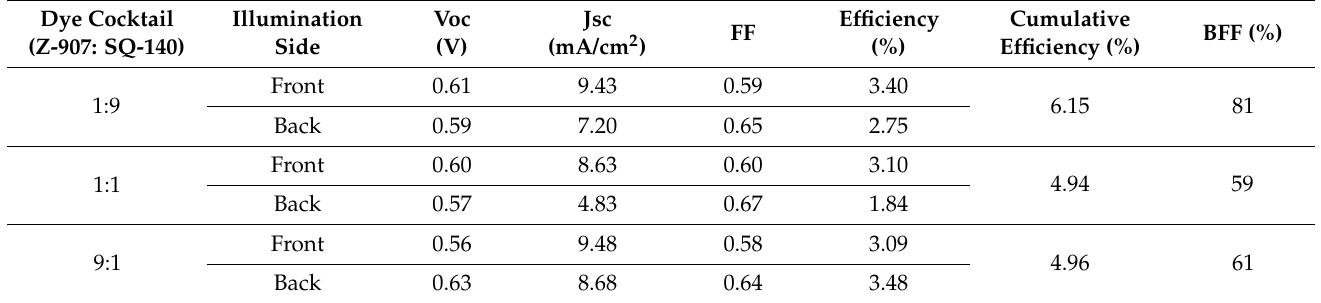
Figure 8. P Photovoltaic characteristics of the BF-DSSCs based on the different dye cocktails of Z-907 and SQ-140 with dye adsorption for 4 h after the front and rear simulated 1 Sun irradiation ( a ) and corresponding absorption for photoanodes taken from different cocktails after 4 h of dye adsorption ( b ). Table 4. Photovoltaic parameters of bifacial DSSCs of visible (Z-907) and NIR (SQ-140) dyes for the 4 h of dye adsorption from the di ff erent dye cocktail solutions taken in di ff erent molar ratios.